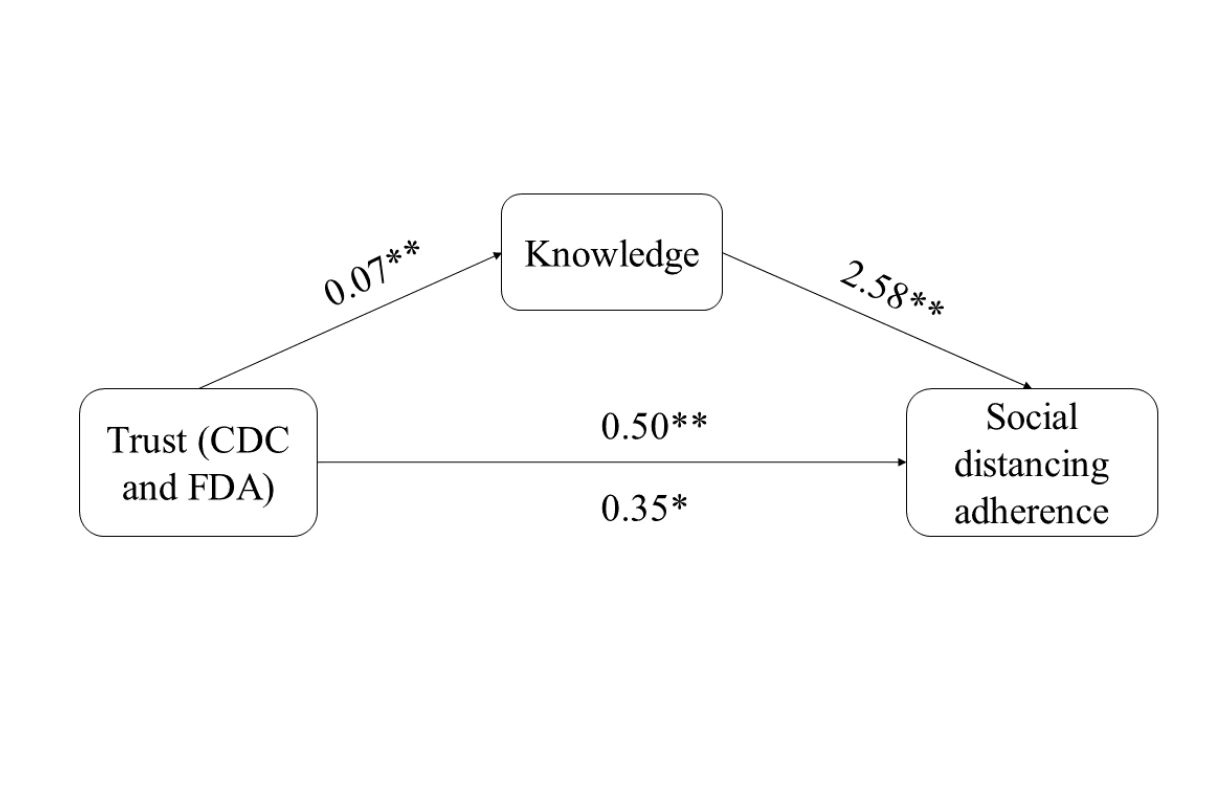
Figure 1. Indirect effects of trust in CDC and FDA information sources and adherence to social distancing. CDC: US Centers for Disease Control and Prevention; FDA: US Food and Drug Administration. *Significant at .05, **significant at